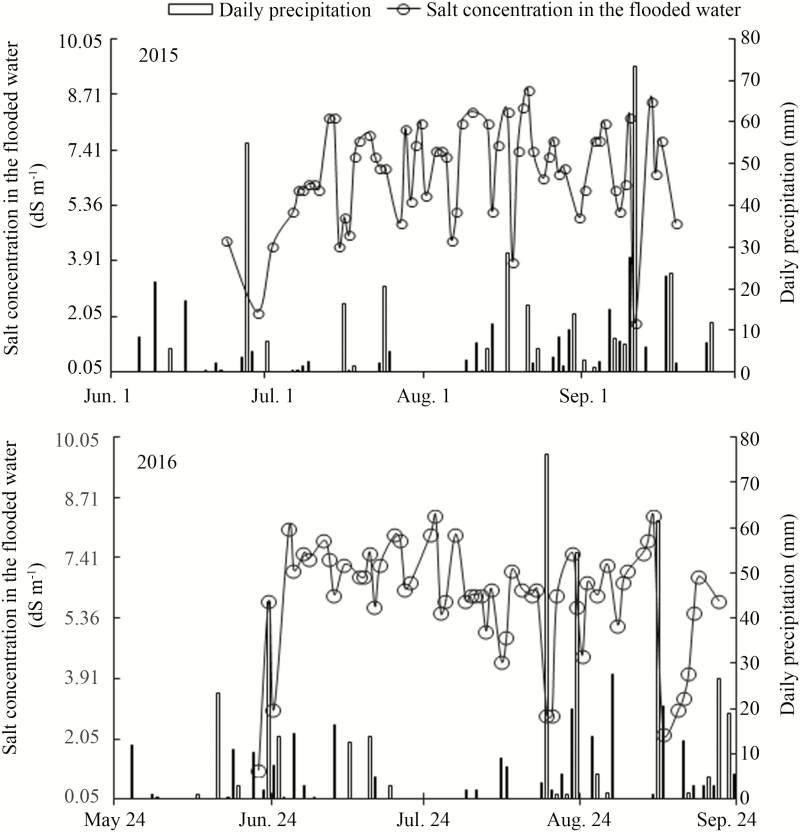
Changes in salt concentration in the flood water of the saline well water-irrigated paddy field in 2015 and 2016. Daily rainfall during the experiments is also shown. The salt concentration in the flood water shown was measured before adjusting it to 7.41 dS m−1. Salt concentration in the flooded water of the control field was under the detection limit of the equipment (<0.21 dS m−1). Transplanting was done on 28 May in 2015 and 24 May in 2016. Salt treatment was initiated on 24 June in 2015 and 21 June in 2016 when plants were actively tillering, till harvest on 25 September in 2015 and 23 September in 2016. Harvest for measurement of Na+, K+ and Cl− concentrations was performed on 1 September in 2016.